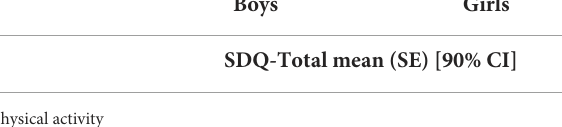
scores. Model 3 included all potential paths, and its model fit indices were considered to be good. The results of this model including autoregressive paths, adjacent cross-lagged paths, and covariates are reported in Table 6. For boys, the autoregressive paths between adjacent and distant time points were significant for hyperactivity/inattention and PA (only in adjacent paths). The stability of SDQ- H/I decreased slightly for the autoregressive paths over time (beta Baseline − Wave1 = 0.521 to beta Wave1 − Wave2 = 0.495) for SDQ-H/I, whereas the stability of PA increased for the